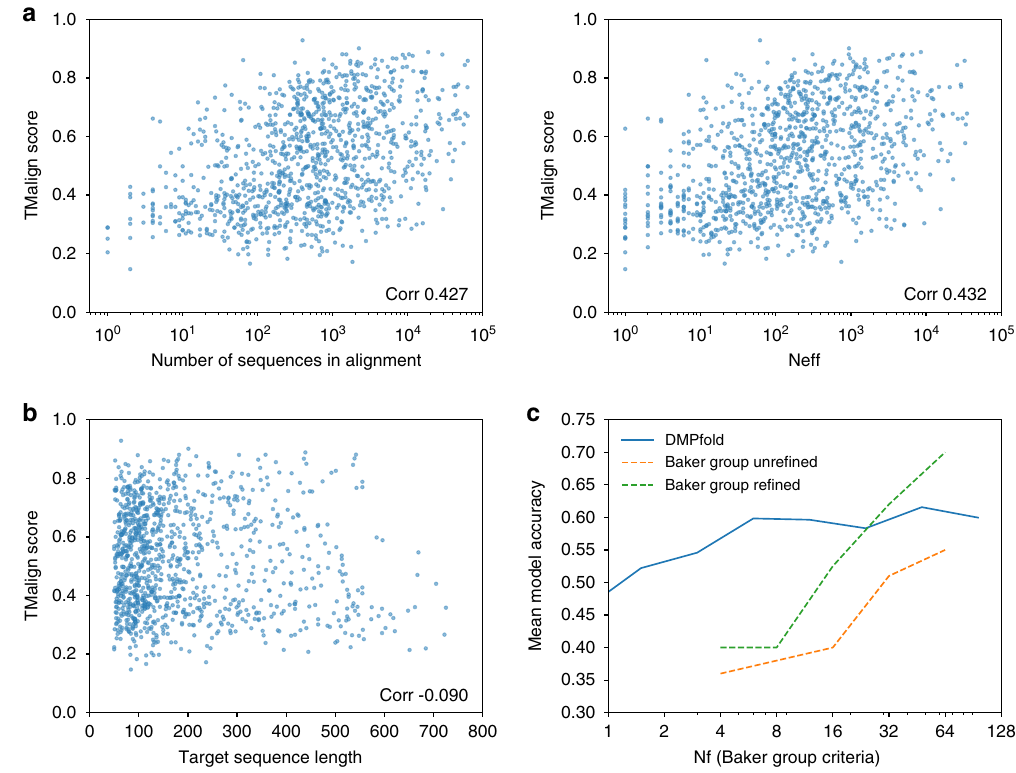
Fig. 5 DMPfold predictions are robust to variations in MSA composition and sequence length. Evaluations are made on the Pfam validation set. a Correlation of TM-align score with alignment depth and effective sequence count N eff , de fi ned in the Methods section. The Pearson correlation coef fi cients are shown. DMPfold is able to generate accurate models for some Pfam families with fewer than 100 sequences in the sequence alignment. b There is little correlation of model accuracy with target sequence length. c In order to compare with ref. 19 , we calculated the N f with their criteria and plotted the mean model accuracy of models in bins of N f values. N f values were calculated as described in ref. 19 , where an 80% identity threshold was used for clustering. Values were read off the graph in Fig. 2 of ref. 19 and added here. It is important to note that the proteins used to obtain our values were different to theirs. It can be seen that DMPfold is effective at lower effective sequence